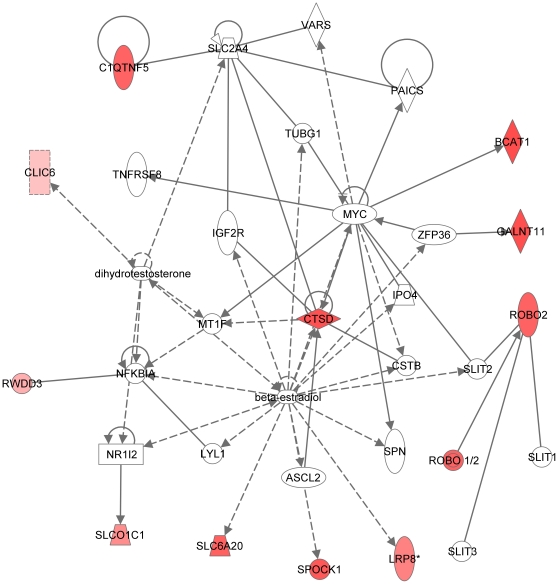
Third significant molecular network generated by Ingenuity.Network is generated from our microarray dataset with RPE-specific expression (114 entries; see text). For explanation of symbols on the diagram see legend Figure 7. The main functionalities given by Ingenuity for this molecular network are cellular movement, nervous system development and function and gene expression. Please note the central signaling role of beta-estradiol; known to affect retinal function and disease.